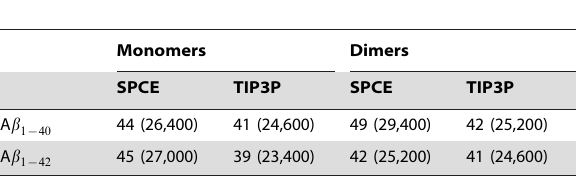
and A b monomer and 1 { 40 1 { 42